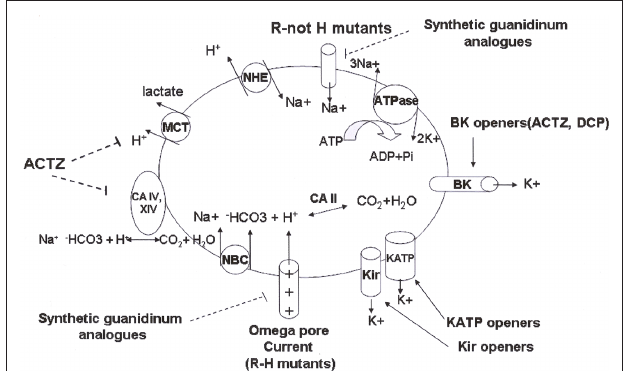
FIGURE 3 | Targets of drug actions of potential interest in the hypokalemic periodic paralysis (modified from Matthews and Hanna, 2010). Acetazolamide or dichlorphenamide are capable to activate the calcium-activated K + channels (BK) at submicromolar concentrations with fiber repolarization. Acetazolamide is also capable to inhibit the monocarboxylate transporter (MCT) reducing the efflux of lactate thereby preventing vacuolar myopathy. This drug also inhibits the membrane bound carbonic anhydrase (CA) enzymes with effects on the extra-/intracellular proton